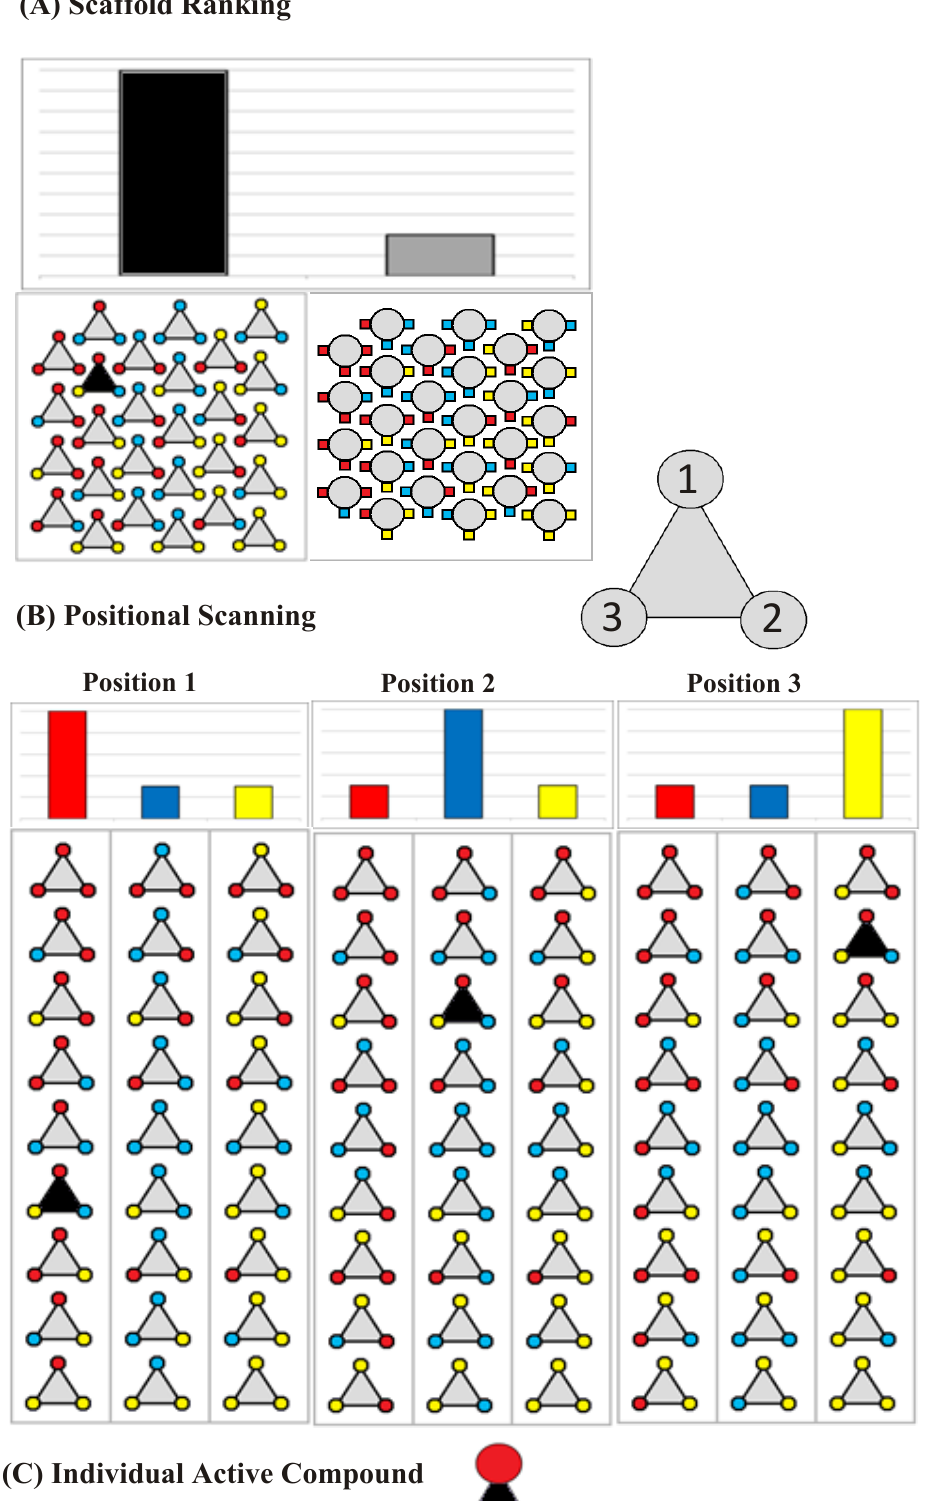
Figure 1. A schematic tracing an active compound (black) through the combinatorial library screening process, from scaffold ranking ( A ) to positional scanning ( B ) to individual compound synthesis ( C